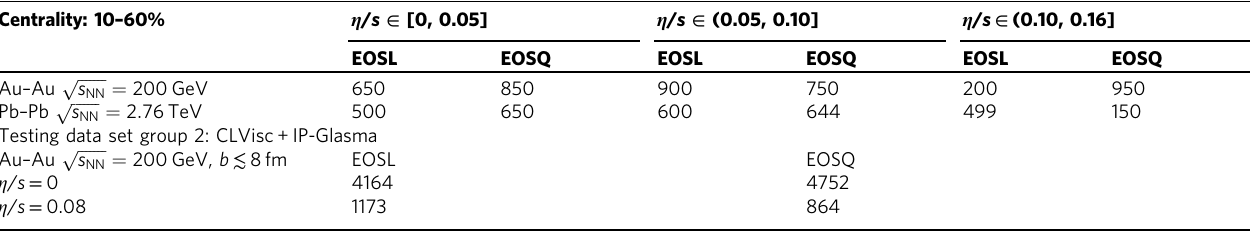
Table 2 The testing data set Testing data set group 1: iEBE-VISHNU + MC-Glauber Centrality: 10 – 60%